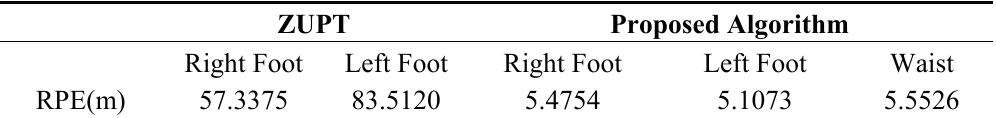
Table 2. Average of RPE of each algorithm after 500 times of Monte Carlo test. Tested trajectory is 400 m of ground course. ZUPT